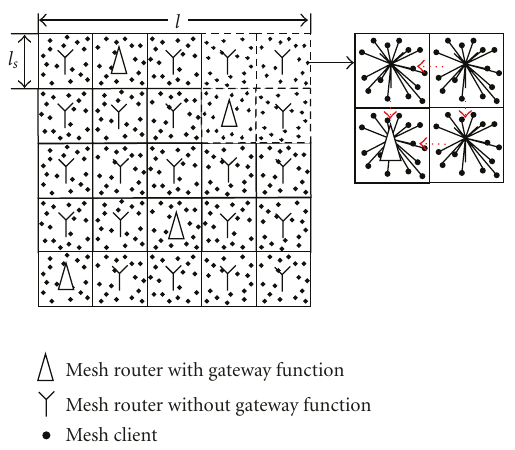
Figure 2: Network topology of an infrastructure WMN with